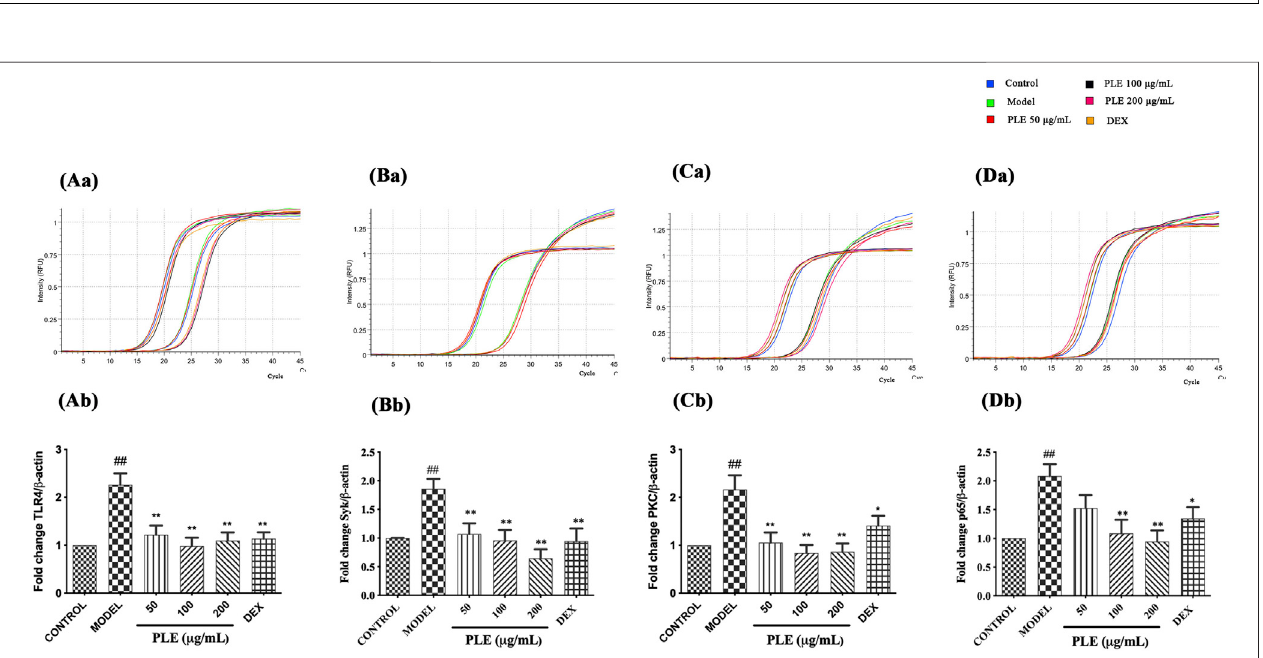
FIGURE5| EffectsofthePLEontheexpressionofTLR4 (A) ,Syk (B) ,PKC (C) ,andNF- κ Bp65 (D) mRNAinLPS-stimulatedRAW264.7macrophagesdetectedby qRT-PCR (n (cid:2) 3). Representative images of the ampli fi cation curve of primer DMM286110 (Tlr4) (Aa) , DMM519482 (Syk) (Ba) , DMM575032 (Prkcd) (Ca) , and DMM880760 (Rela) (Da) as shown above. Data were shown asmean ± SEM; ## p < 0.01 compared with the CONTROL group; * p < 0.05 and ** p < 0.01 compared with the MODEL group.